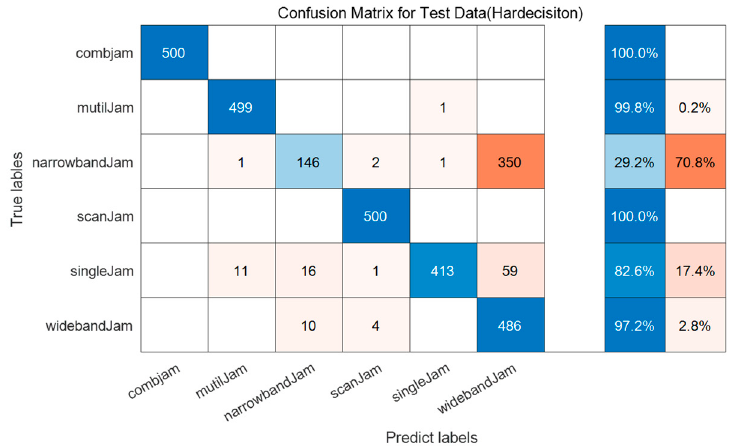
Figure 12. Confusion matrix of the hard-fusion based method (CNN, the number of co-cognitive nodes is 6 under JSR = − 6 dB).